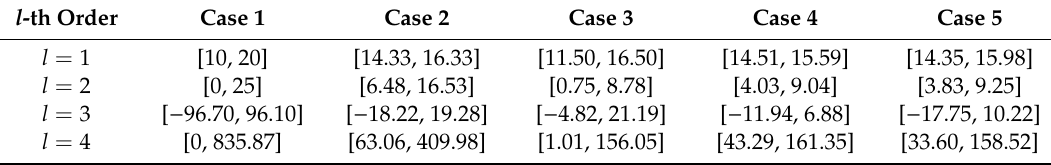
Table 3. Four statistical moments of epistemic uncertainties in example 2.